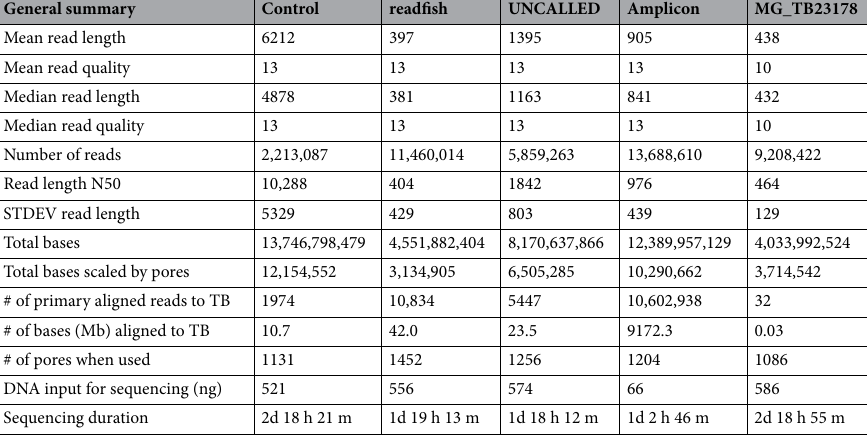
Table 1. Sequencing